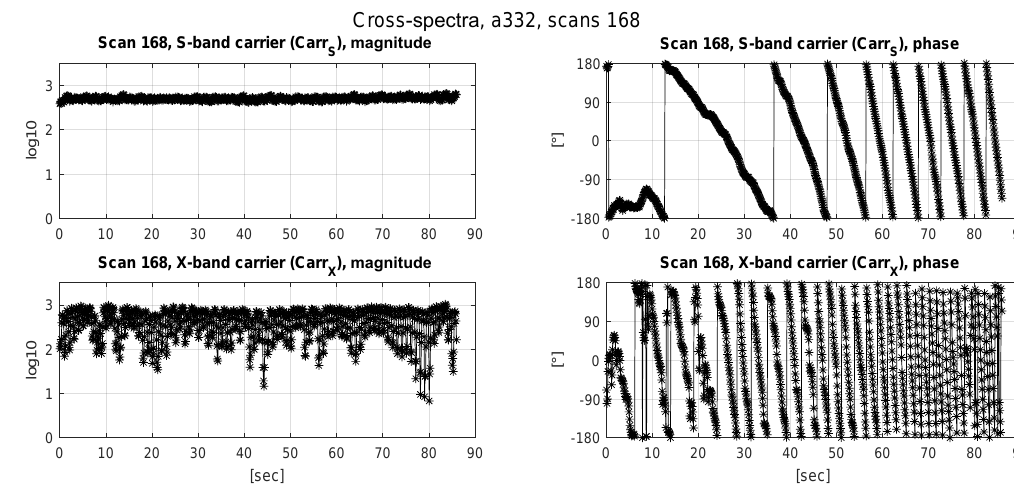
Figure 8. Cross-spectrum magnitudes (left column) and phases (right column) of the S-band (Carr S , upper panels) and X-band (Carr X , lower panels) carrier tones of Scan 168 of Experiment a332. The time axes (horizontal) indicate seconds since the start of Scan 168 (10:41:04